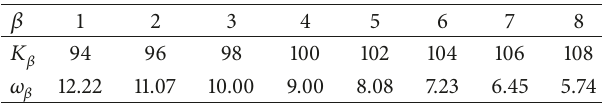
(𝜎;100, 1) − 𝜔 ] 2 /8 on a parameter domain, 0.1 ≤ 𝜎 𝛽 𝛽